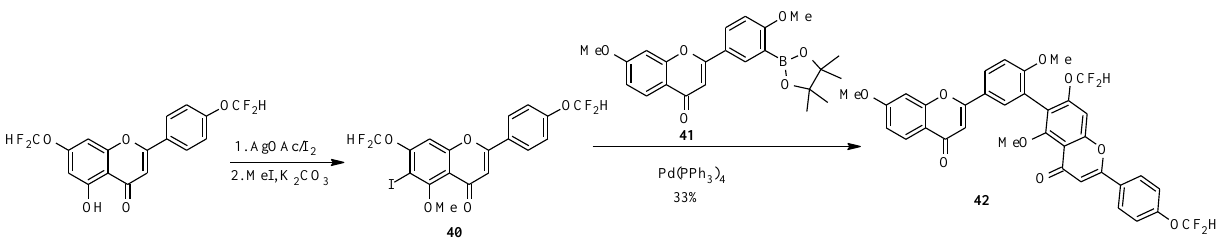
Scheme 11. Preparation of gem -difluoromethylenated biflavones.